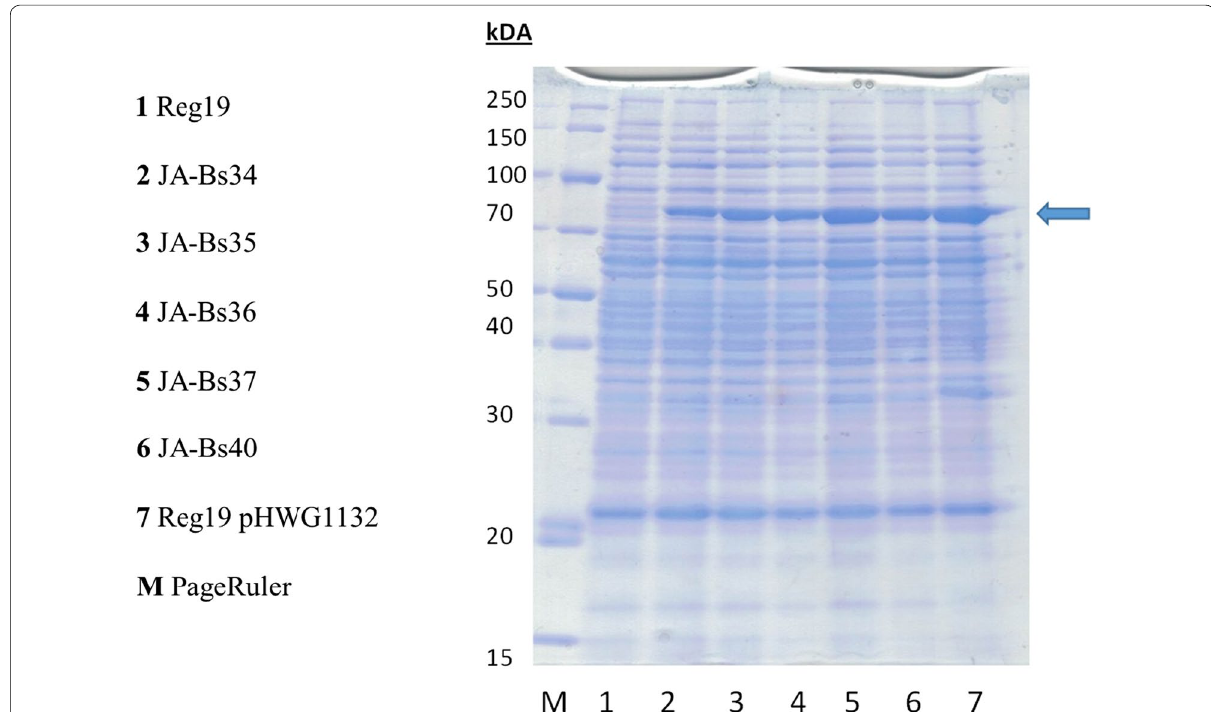
Fig. 4 SDS-PAGE showing the protein crude extracts from REG19, JA-Bs34 to JA-Bs40 and from REG19 carrying the plasmid pHWG1132. Crude extracts were prepared from cells induced by glucitol for 16 h, cleared by centrifugation and the amount of 15 μg cleared crude extract proteins were applied on the SDS-gel in each line. The GanA protein of 79.8 kDa is indicated by the arrow